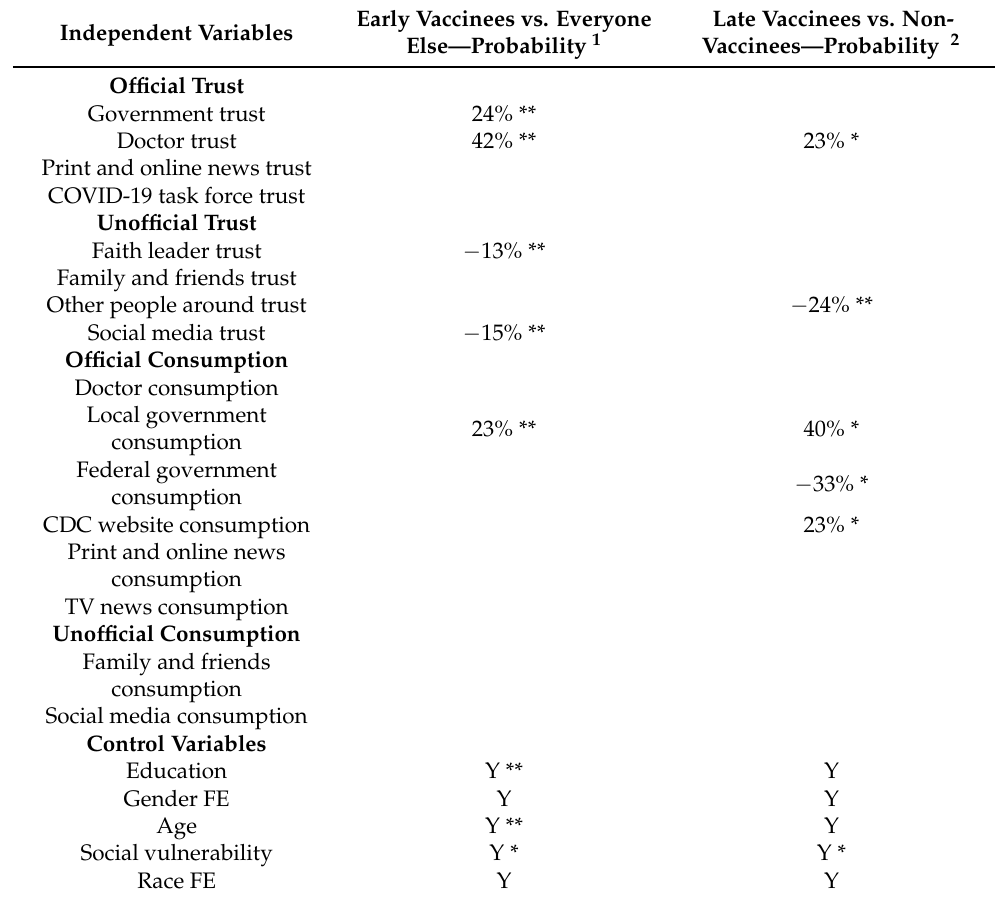
Table A2. Percentage changes as marginal effects of the probit correlation between the probability of being an early/late vaccinee and the education, trust, and consumption variables, while all independent variables of individual trust and consumption variables are incorporated into the same regression. We provide this table as a robustness check to identify the variables with a strong correlation with vaccine uptake whenever other variables are controlled. Early Vaccinees vs. Everyone Late Vaccinees vs. Non- Independent Variables Else—Probability 1 Vaccinees—Probability 2